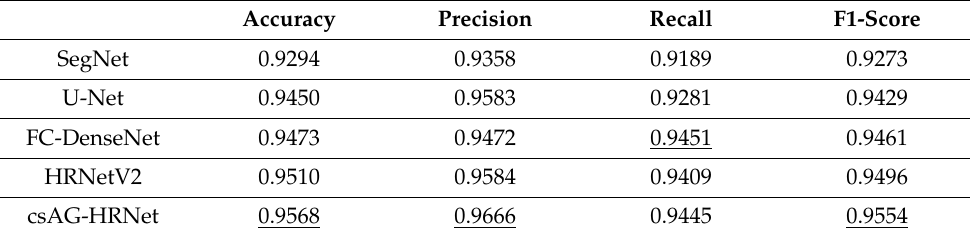
Table 3. Quantitative building extraction results for site 1 (industrial area) according to each deep learning model.